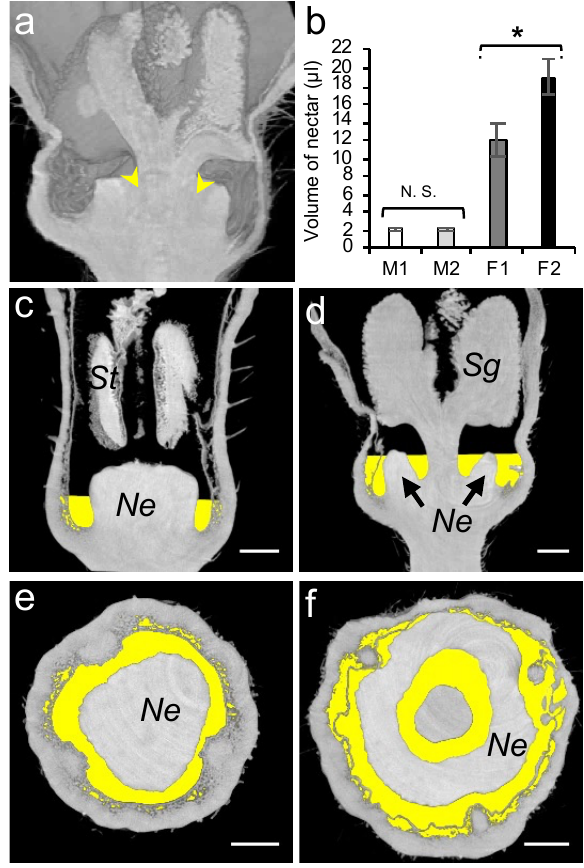
Figure 6. Analysis of nectar volumes of male and female melon flowers at anthesis stage. ( a ) Nectar left in female flower after glass capillary pipetting is indicated by yellow arrows. ( b ) Nectar volume in male (M) and female (F) flowers measured using glass capillary pipettes with (M2 and F2) and without flower dissection (M1 and F1). St, stamen; Sg, stigma; Ne, nectary; and N.S., not significant; * = p < 0.05. Microtomographic transversal and semi‑sagittal views of male ( c , e ) and female ( d , f ) flowers showing nectar volumes in yellow. The scale bar represents 1 mm.